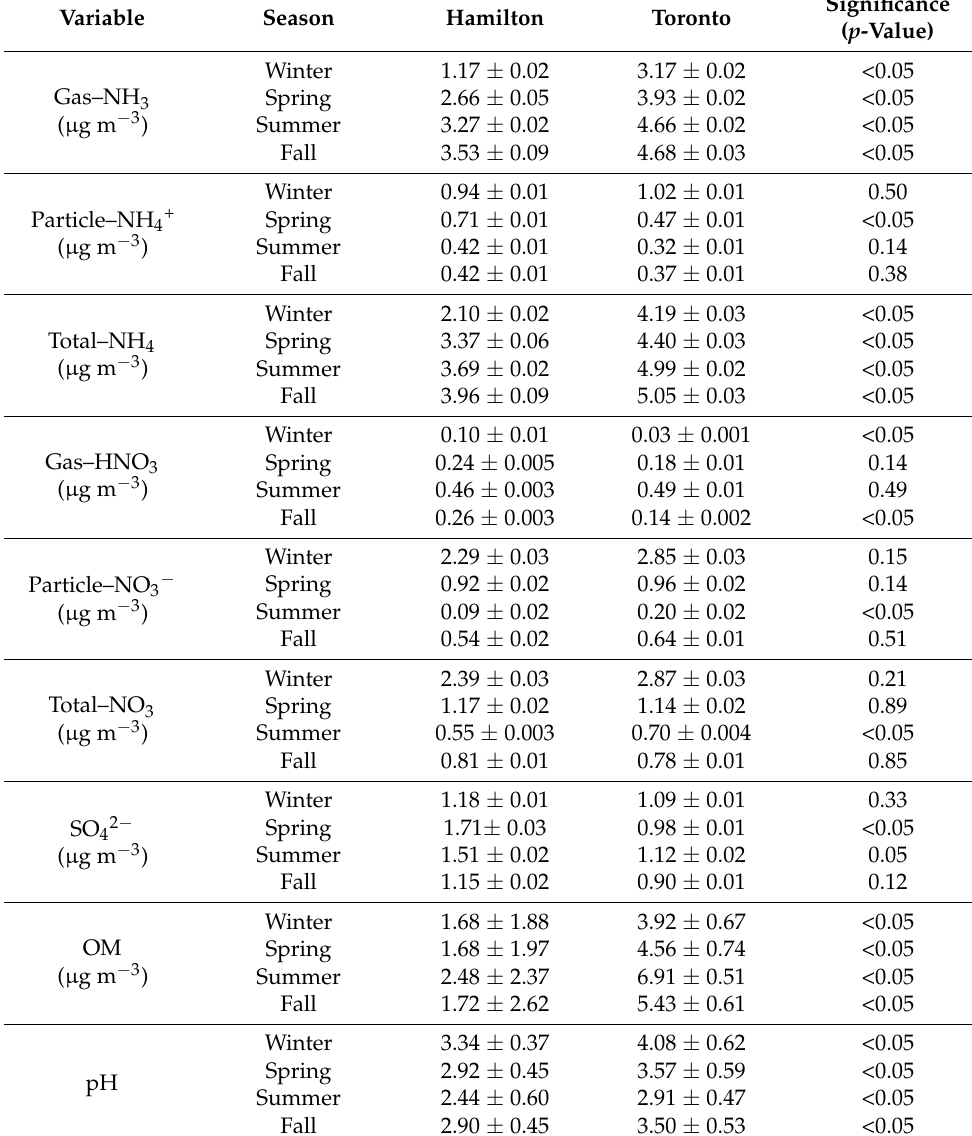
Table 1. Chemical composition of major aerosol particles, gas-phase species, and aerosol pH in Hamilton and Toronto. For all chemical species, seasonal average and standard error of concentrations are reported in µ g m − 3 . The significance ( p -value) of the difference in seasonal concentration of each variable in the two sites is calculated using a two-way ANOVA test with a significance level of 0.05. Variable Season Hamilton Toronto